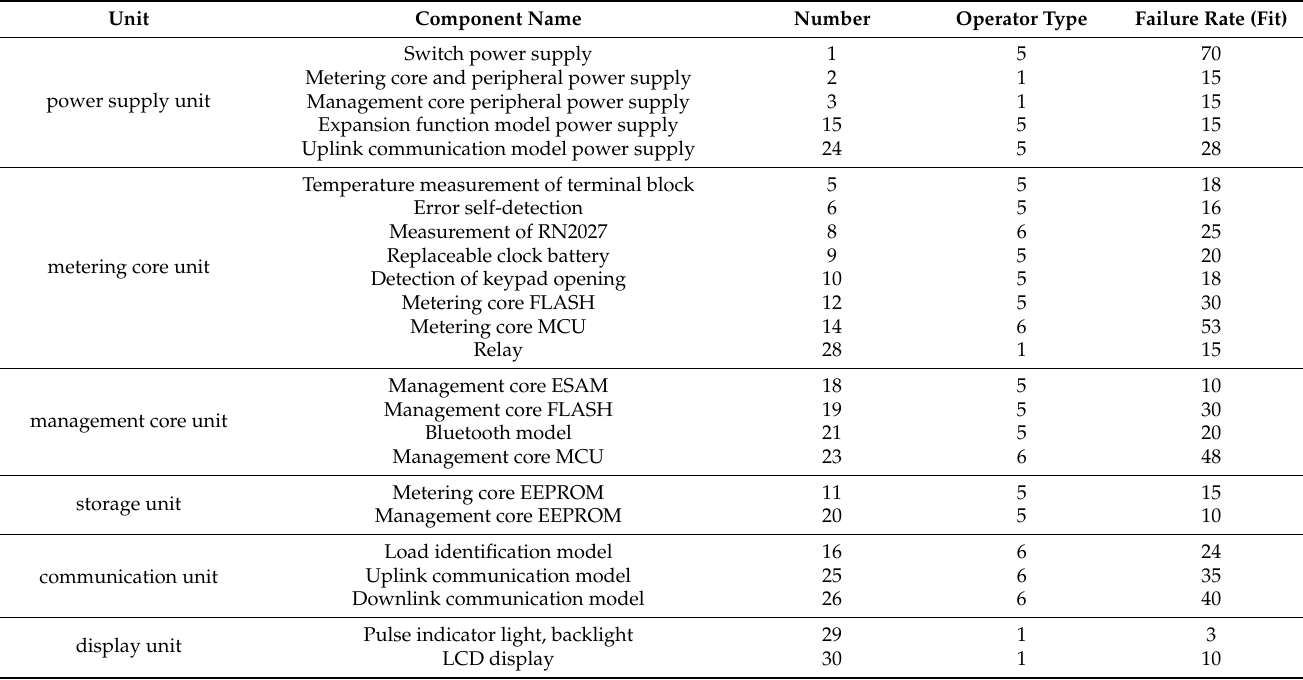
Table 2. Operator data.